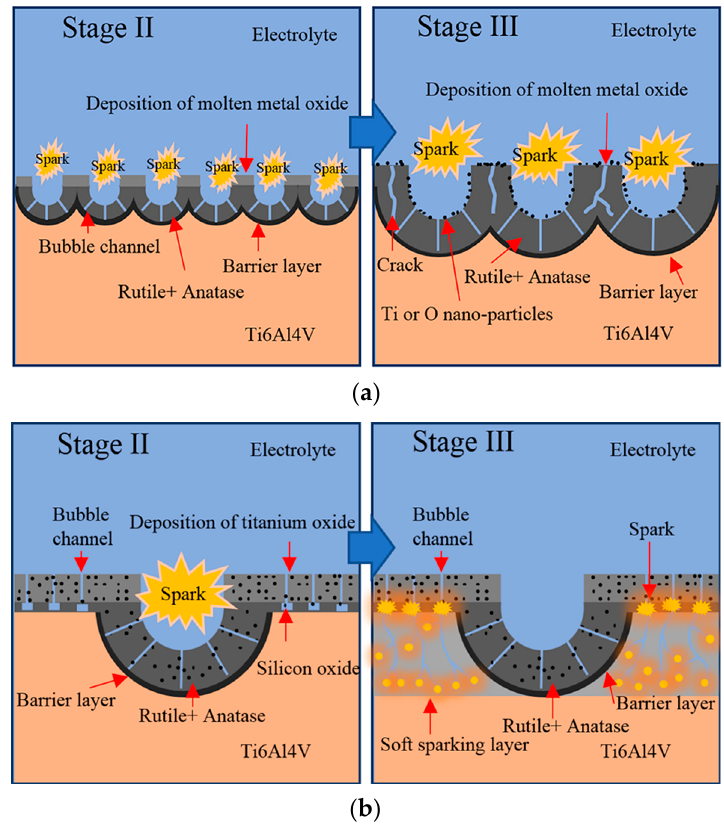
Figure 9. The mechanisms of soft sparking discharge during MAO in the ( a ) Na 2 B 4 O 7 electrolyte and NaF electrolyte, and the ( b ) Na 2 SiO 3 electrolyte and Na 3 PO 4 electrolyte.